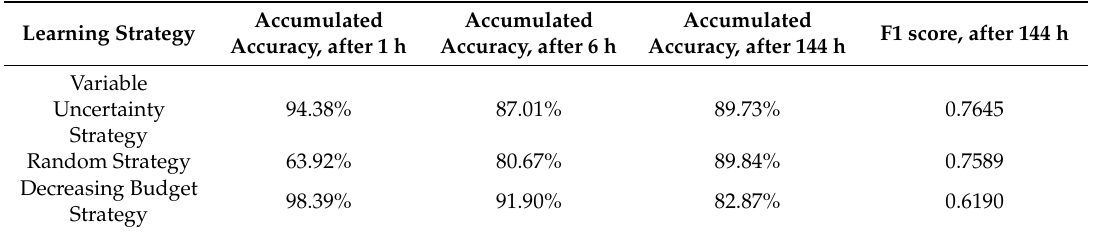
Figure 4. The accumulated accuracy for Variable Uncertainty Strategy vs. Random Strategy vs. Decreasing Budget Strategy. Table 2. The accumulated accuracy and F1-score for learning strategies in dynamic settings.